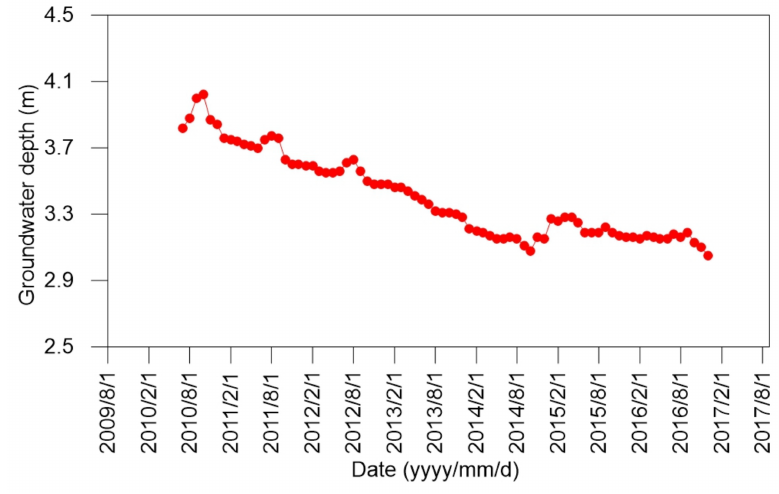
Figure 6. Long-term groundwater depth at location W01 near the Qingtu Lake